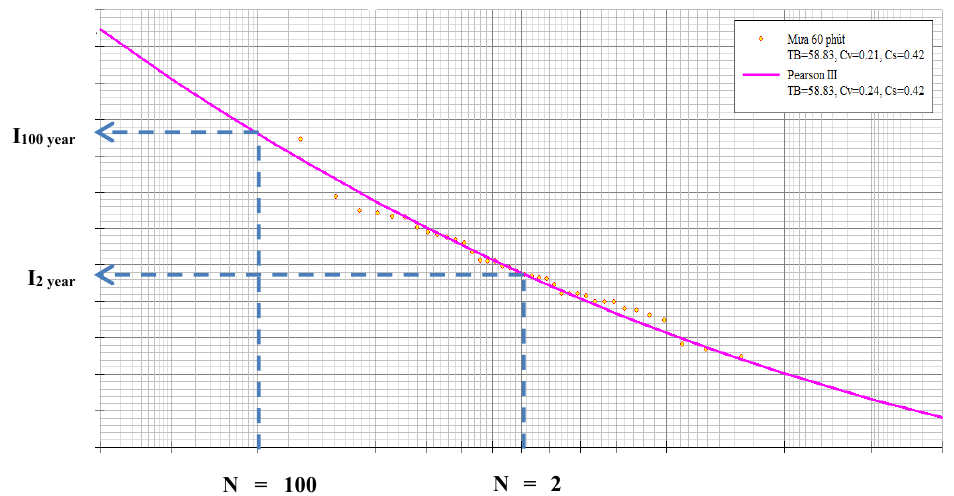
Figure 3. Frequency curve of cumulative rainfall distribution, rainfall duration 60 min. TB denotes the average rainfall value, C v the denotes Coefficient of Variation, C s denotes the Coefficient of skewness.